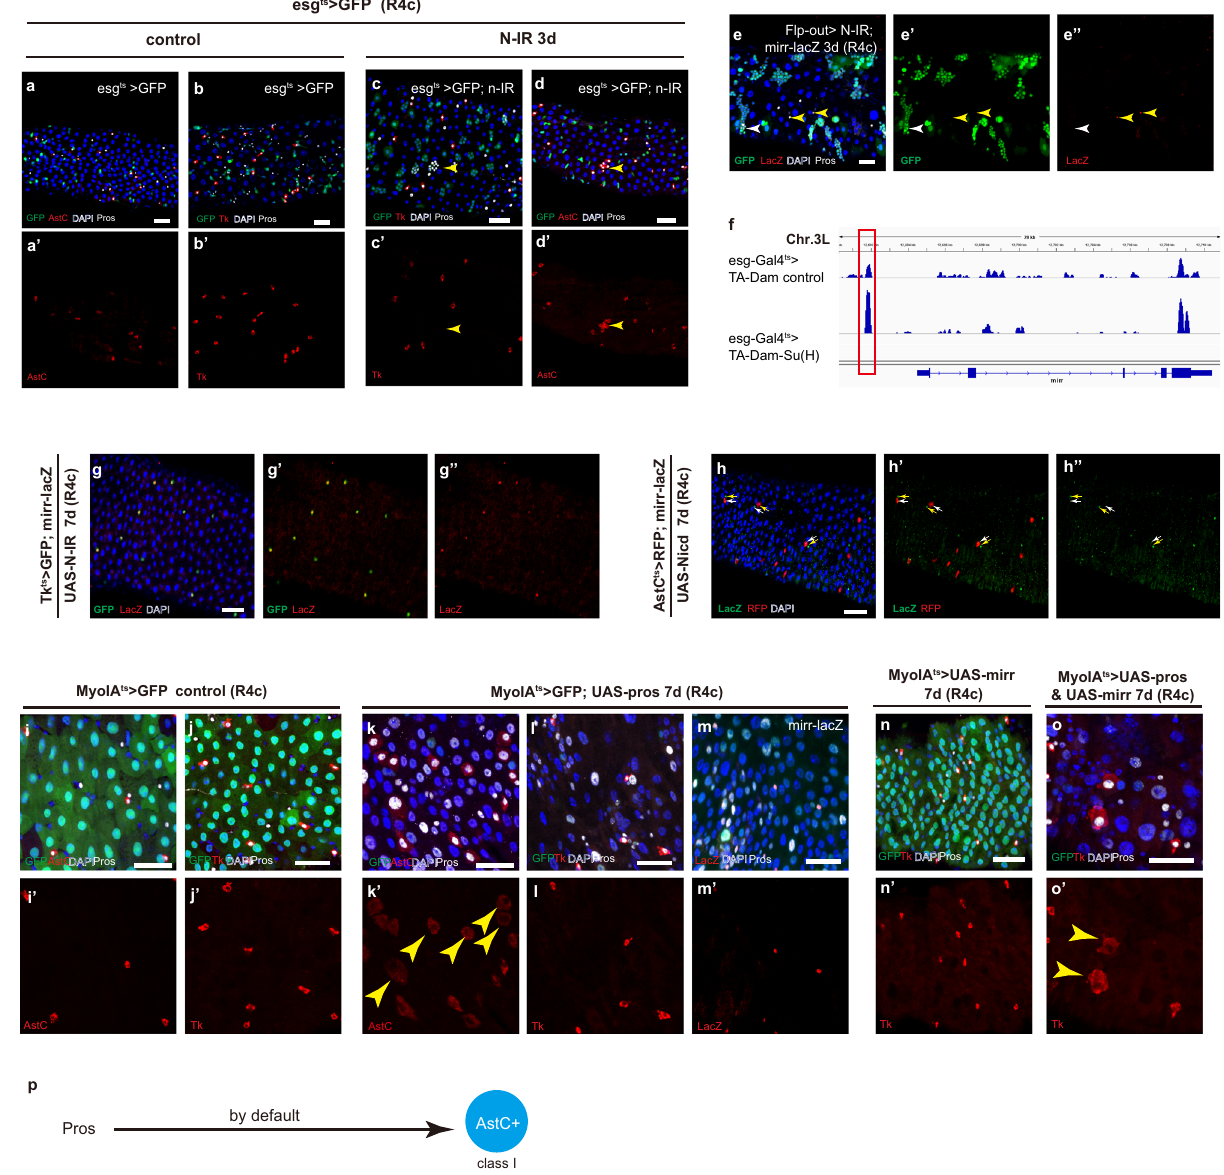
Fig. 4 | The developmental regulation of class I versus class II subtype speci- fi cation. a – d Knocking down Notch in progenitor cells using esg-Gal4 ts leads to generationof Pros + EEclustersexpressingAstC(yellowarrowheadin c ),butnotTk (yellow arrowhead in d ); e the EE clusters in Notch mutant clones do not express mirr (white arrow head); f a graph showing enriched binding of Su(H) proximal to TSS site of mirr in progenitor cells, ashighlighted inthe red box. g Knocking down Notch in Tk + class II subtypes fails to down-regulate mirr-lacZ expression (yellow arrow heads); h Ectopic activation of Notch signaling in AstC + EEs fails to induce mirr expression(yellowarrowheads);Innormalguts,AstC( i )andTk( j )expression are restricted to Pros + EEs; k ectopic expression of Pros in ECs activates AstC